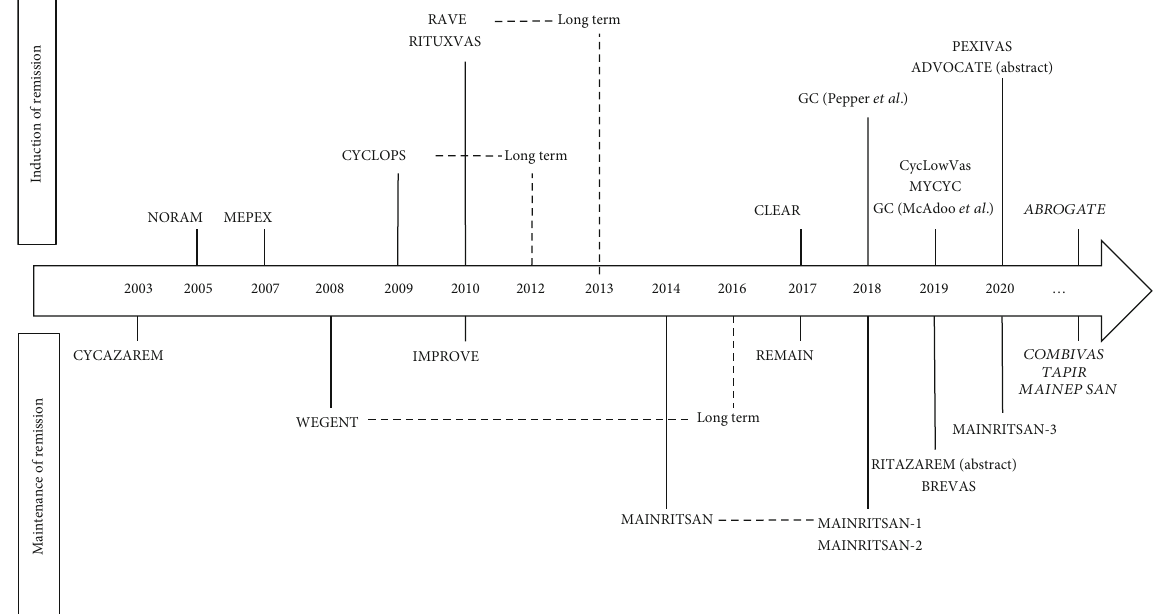
Figure 1: Timeline of hallmark trials of ANCA-associated